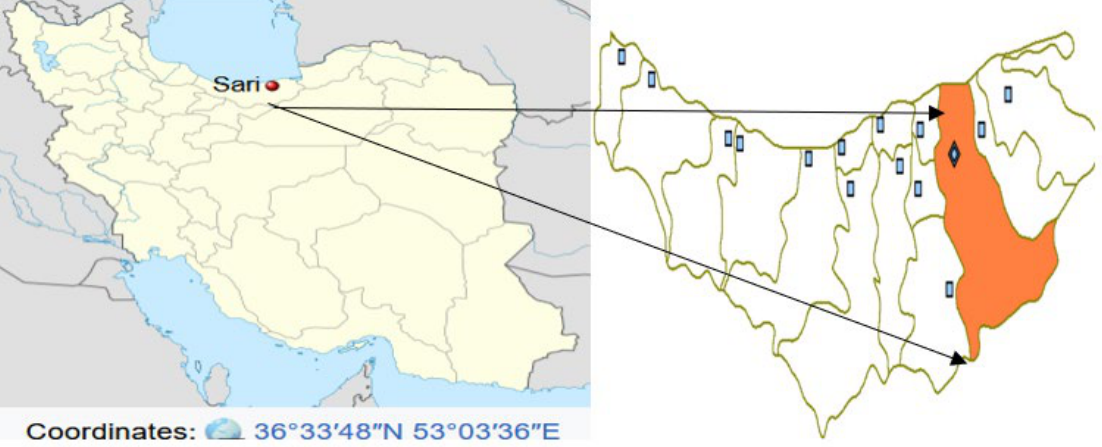
Figure 1. Geographical location of Sari County in Mazandaran Province (Northern Iran).